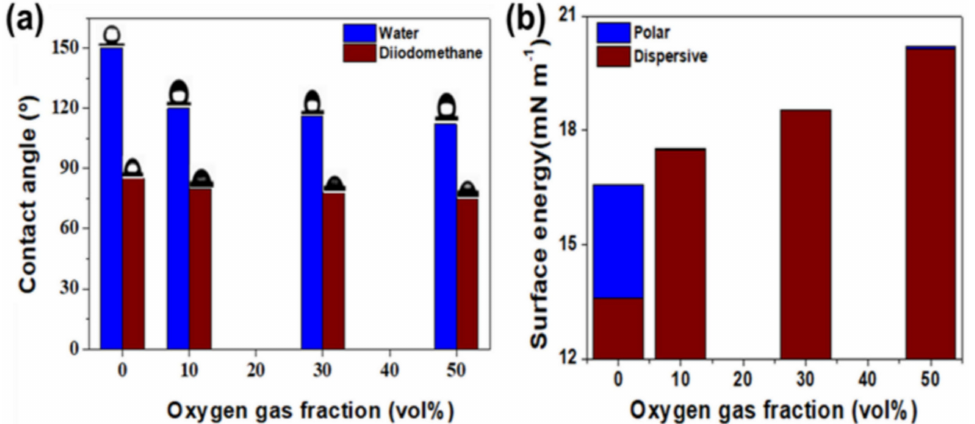
Figure 5. ( a ) Contact angle of water and diiodomethane with the oxygen gas fraction during oxyfluorination and ( b ) surface energy of the polar and dispersive components calculated from the contact